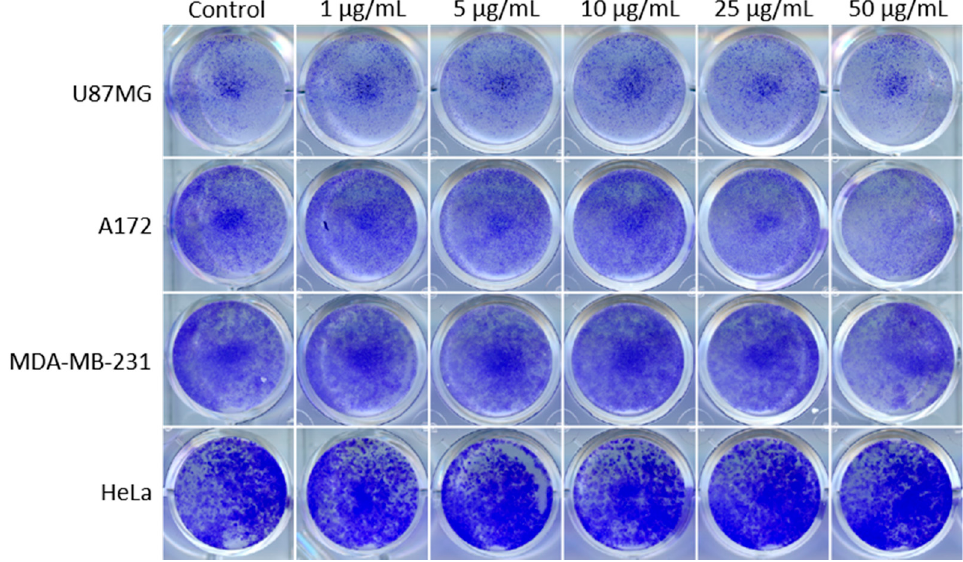
Figure 3. Colony growth of U87MG (human GB cells), A172 (human GB cells), MDA-MB-231 (human breast cancer cells), and HeLa cells (human cervical cancer cells) treated with 1–50 µg/mL of PEI-MSNs. All cells were cultured in standard cell culture conditions.